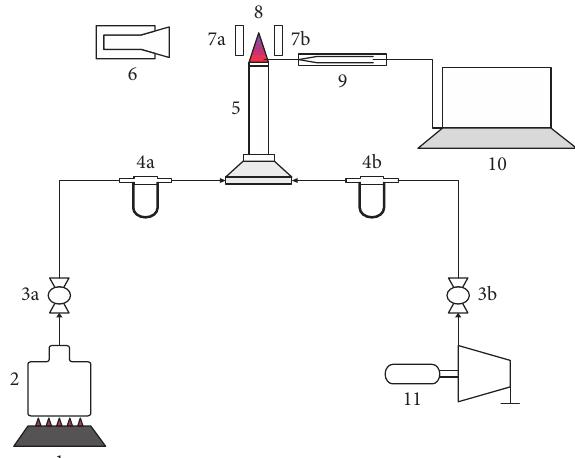
Figure 1: Experimental Apparatus: (1) Stove; (2) boiler; (3) valve; (4) flow control; (5) burner type cylinder; (6) high-speed camera; (7) permanent magnet; (8) flame; (9) thermocouple; (10) data logger; (11)